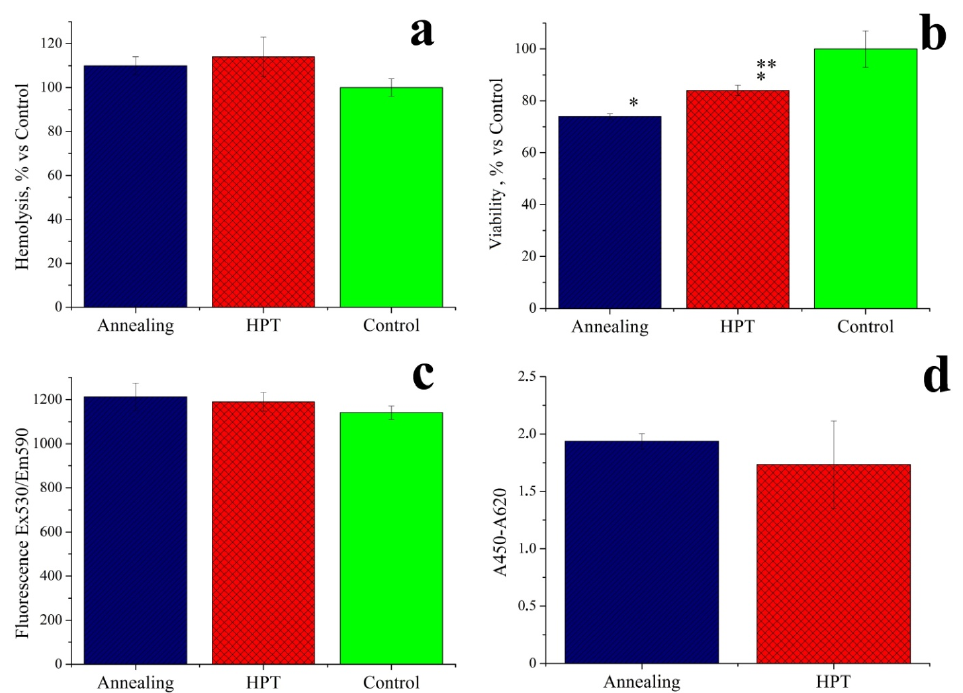
Figure 7. ( a )—hemolytic activity of the Zn-1%Mg-0.1%Ca alloy before and after HPT in comparison with control; ( b )—viability of white blood cells in comparison with the control (* significant difference from the control, p < 0.05; ** significant difference from the alloy of the same composition after HPT treatment, p < 0.05)); ( c )—growth of E. coli bacteria with samples of zinc-based alloys; ( d )—stimulation of colonization on the surface of samples of studied materials by osteogenic cells.